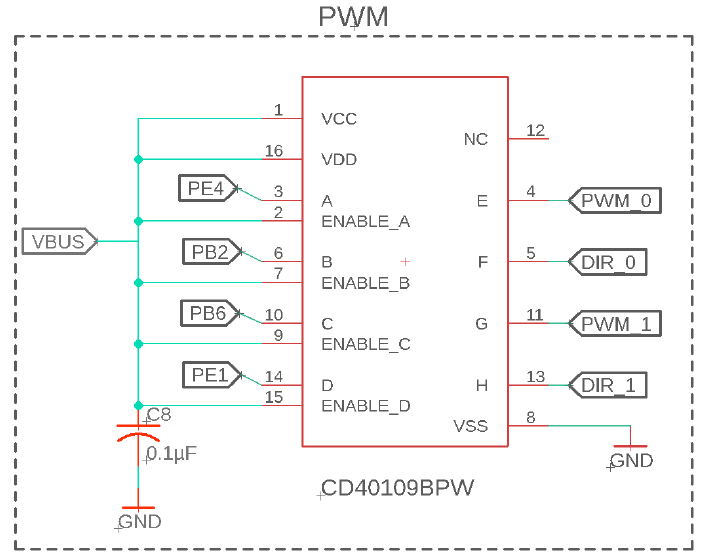
Figure 5. Level shifting from 3.3 V to 5 V logic of the PWM and direction signals for the motor controller